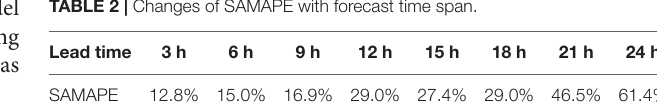
TABLE 2 | Changes of SAMAPE with forecast time